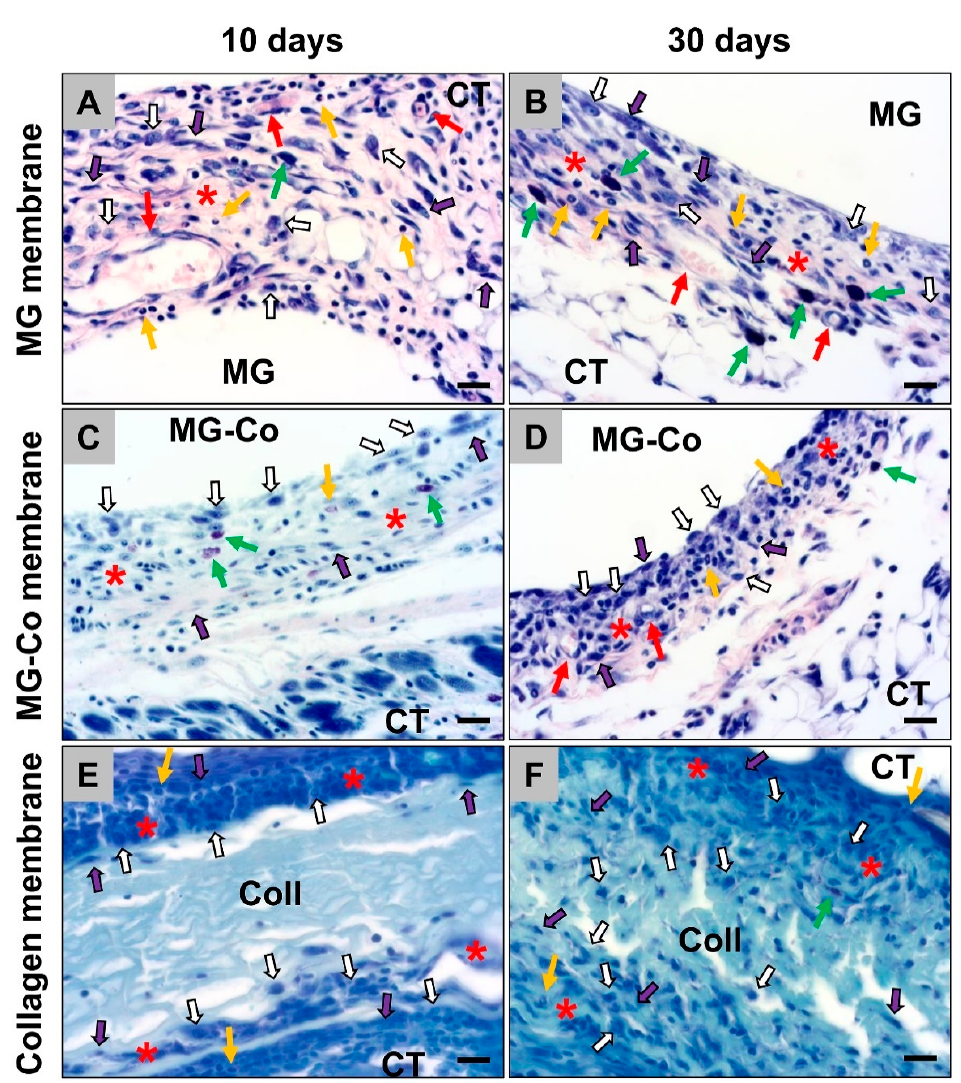
Figure 3. Exemplary histological images of the tissue reactions to the three different membrane types, i.e., the pure magnesium membrane (MG) ( A , B ), the coated magnesium membrane (MG-Co) ( C , D ) and the collagen membrane (Coll) ( E , F ), within the subcutaneous connective tissue (CT) at day 10 and 30 post implantation. Red asterisks = reactive cell multilayer at the material surfaces, white arrows = macrophages, yellow arrows = eosinophils, purple arrows = fibroblasts, green arrows = mast cells, red arrows = blood vessels (Giemsa staining, 400× magnification, scale bars = 10 μ m).